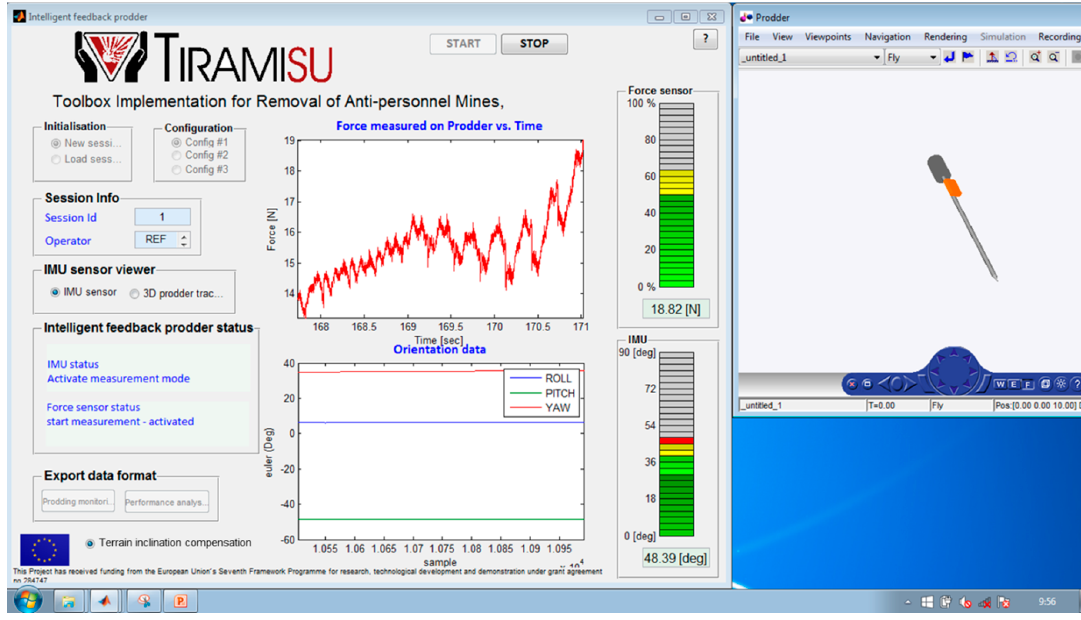
Figure 4. HMI for the intelligent feedback prodder.